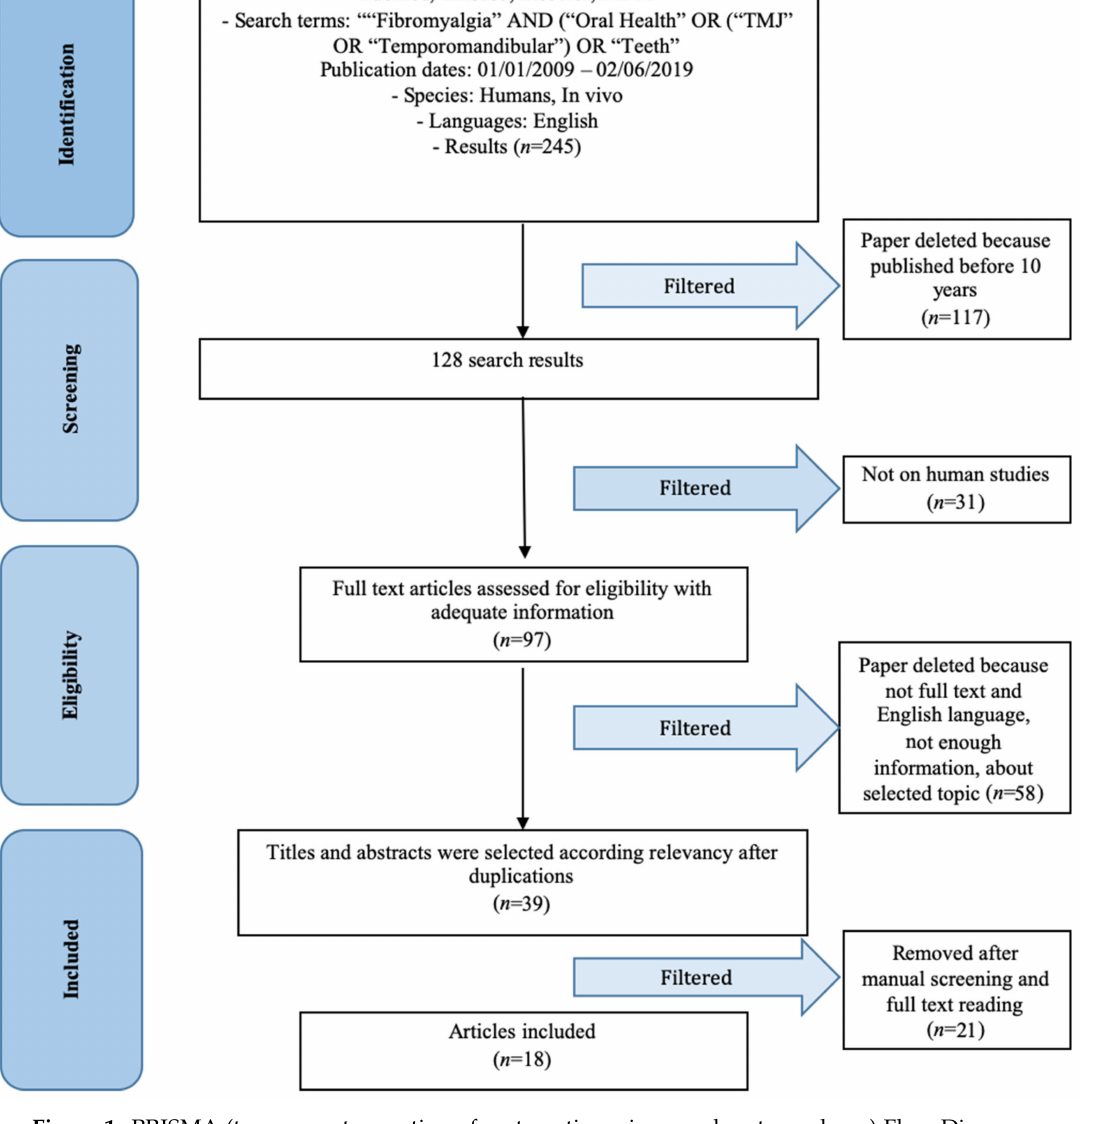
Figure 1. PRISMA (transparent reporting of systematic reviews and meta-analyses) Flow Diagram. The flow diagram depicts the flow of information through the di ff erent phases of a systematic review. It maps out the number of records identified, included and excluded, and the reasons for